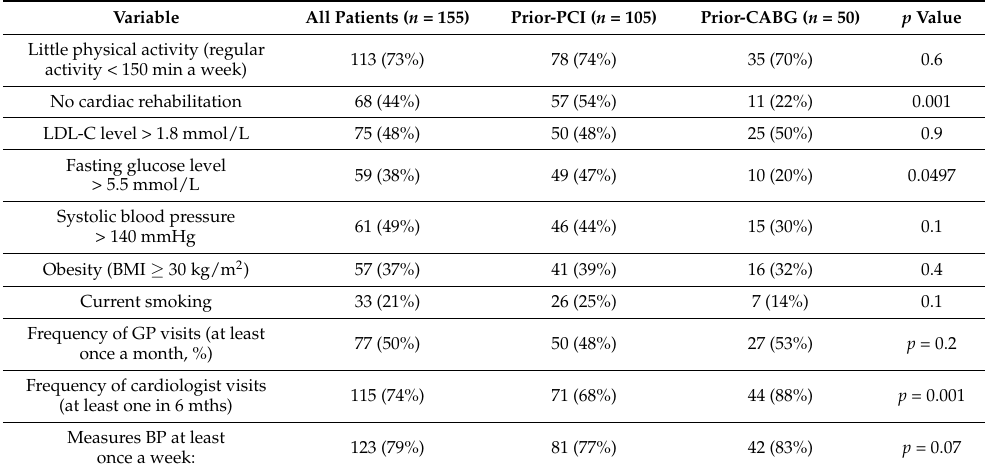
Table 3. Comparison of particular CAD risk factors in study